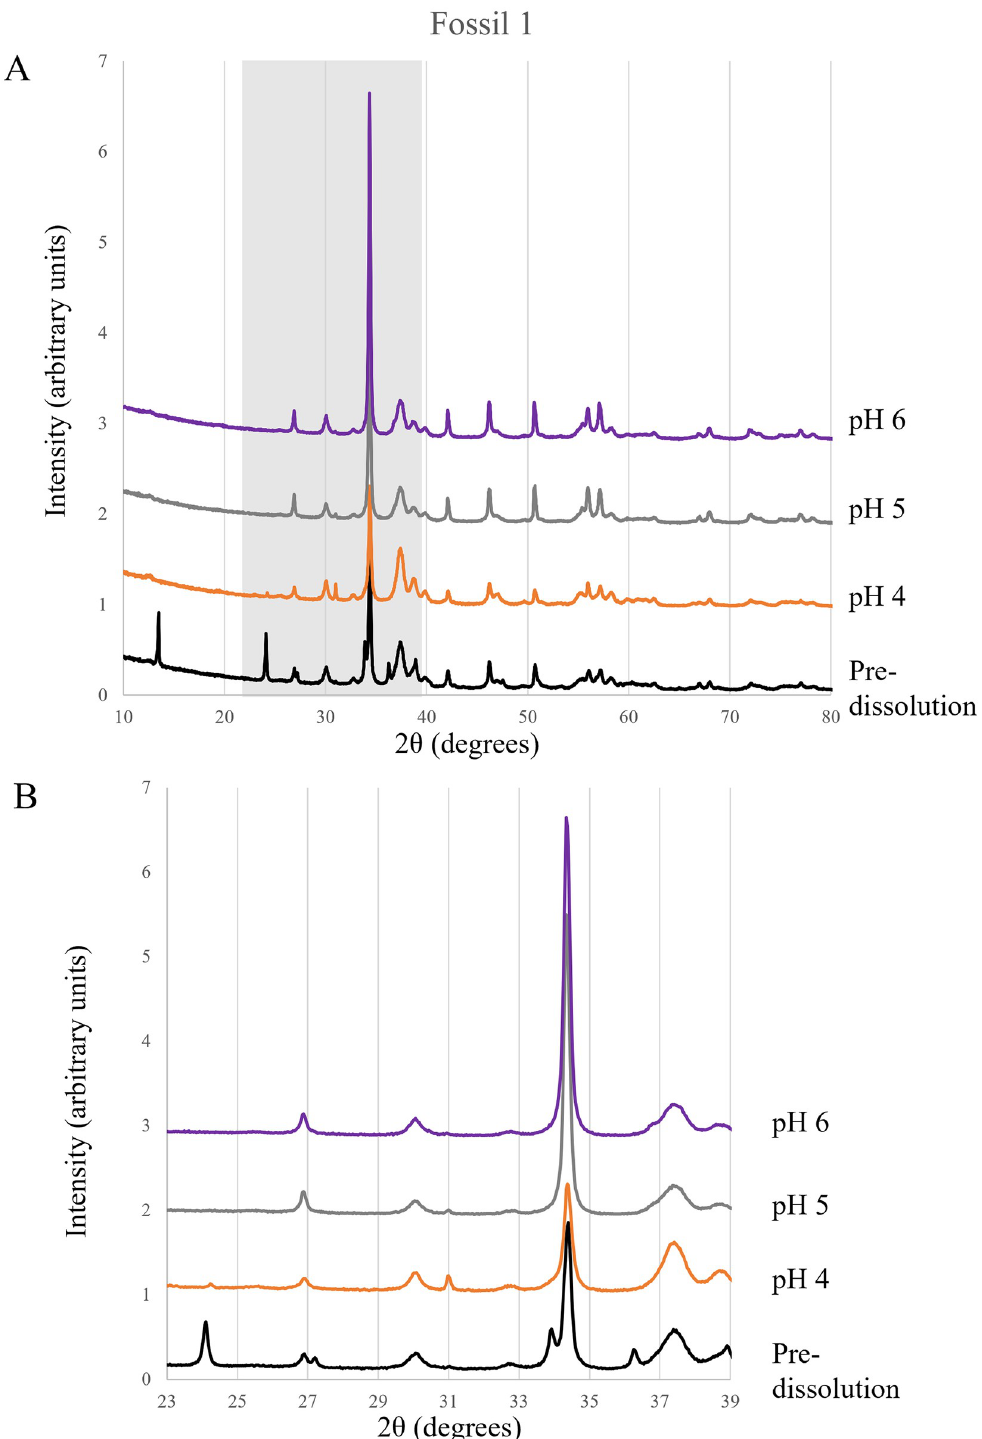
Fig 2. XRD diffractogram patterns for all F1 samples. (A) Stacked diffractograms for all F1 samples. The area highlighted in gray (23–39 degrees) is shown in greater detail in B. (B) Detailed view of the F1 diffractogram pattern from 23–39